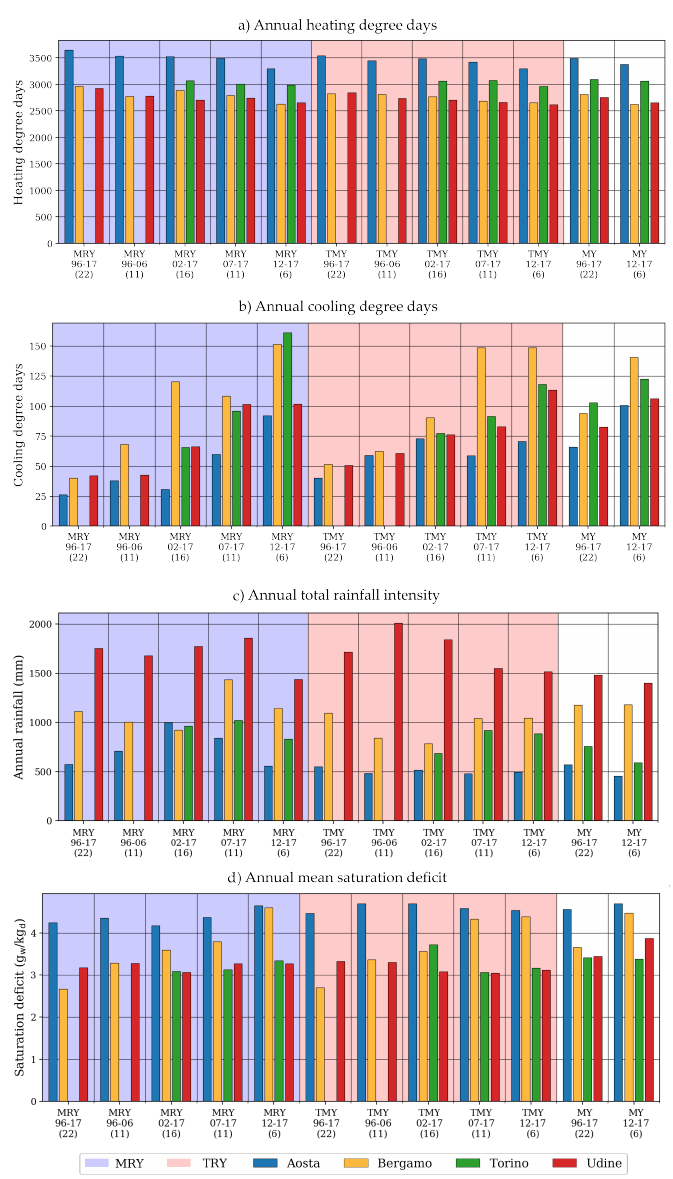
Figure 8. Annual heating degree days ( a ) and annual cooling degree days ( b ), annual total rainfall intensity ( c ) and annual mean saturation deficit ( d ) of the generated years. The background is blue for the Moisture Representative Years (MRY) and red for the Typical Meteorological Years (TMY). The MY bars (white background) are the average values of the multi-year of respectively 22 (total weather record) and 6 years (last years of the weather record). The multi-year of Torino is calculated with 16